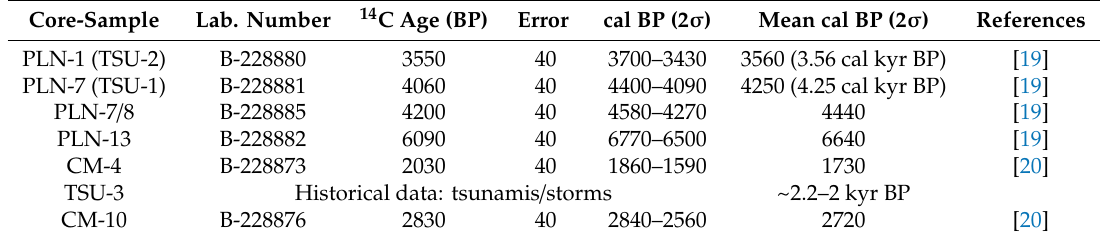
Table 2. Database of the 14 C results and historical data